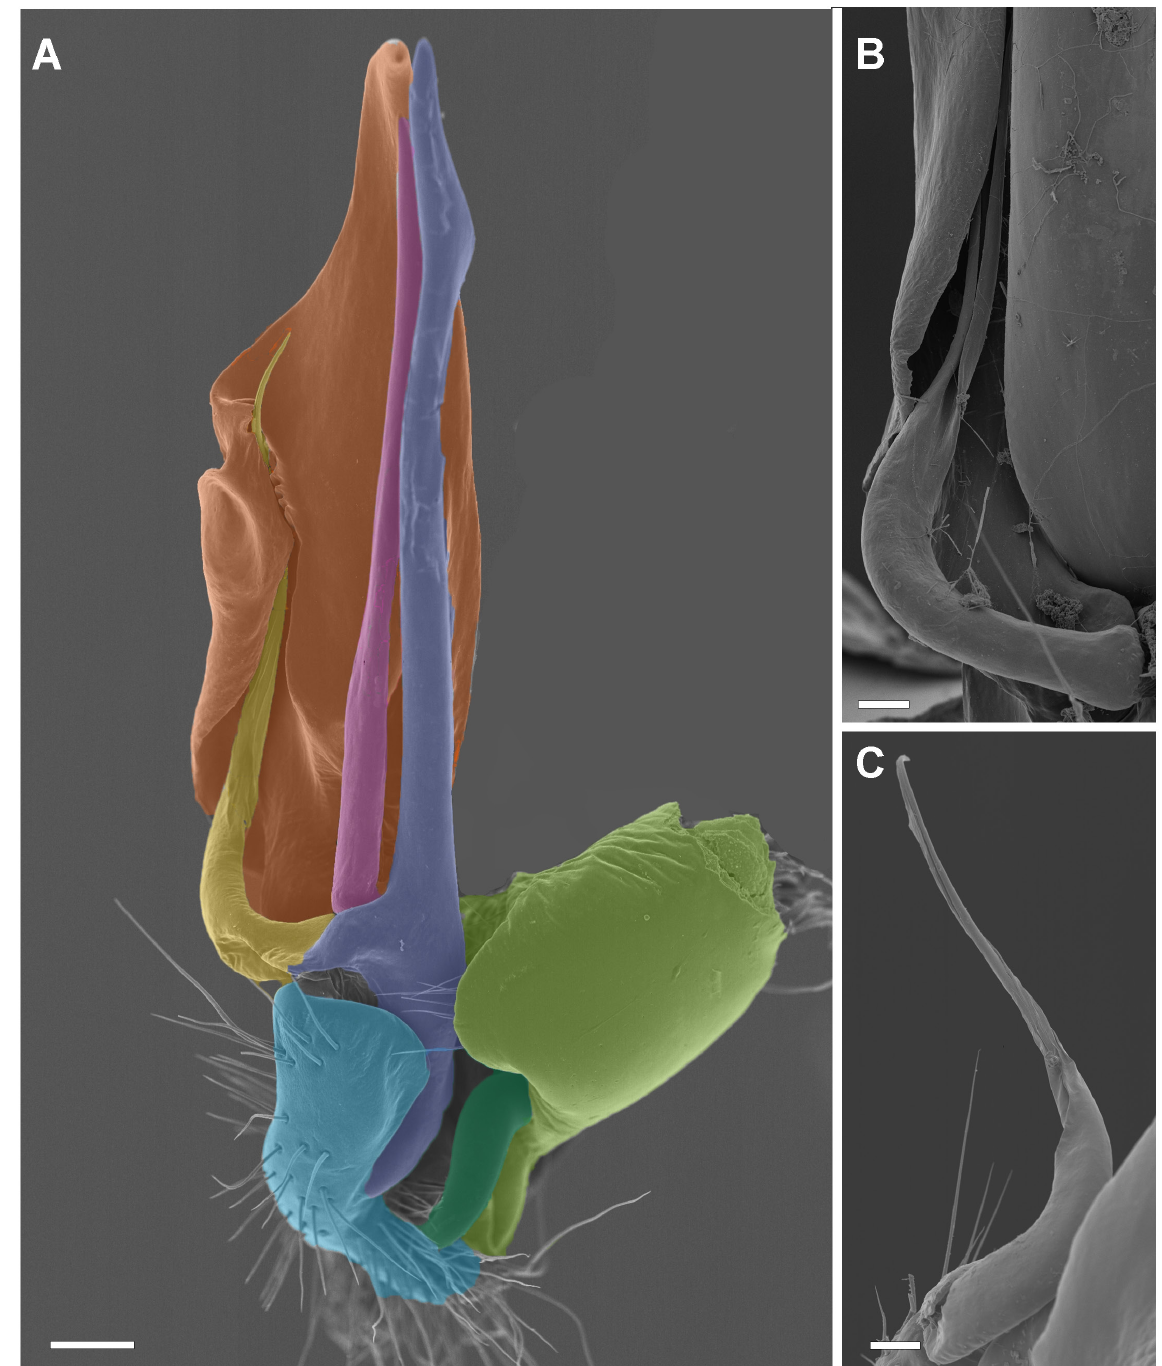
Fig. 8. Gonopods in Eviulisoma spp. A . E. akkariae sp. nov., paratype, right gonopod, colour-coded: light green = coxa; dark green = cannula; light blue = prefemoral part; purplish blue = mesal acropodital process; pink = intermediate acropodital process; orange = solenophore; yellow = solenomere. B . E. culter sp. nov., paratype, right gonopod, solenomere entering solenophore. C . E. ottokrausi sp. nov., paratype, left gonopod, solenomere dislodged from solenophore. Scale bars: A = 0.1 mm; B–C = 0.05